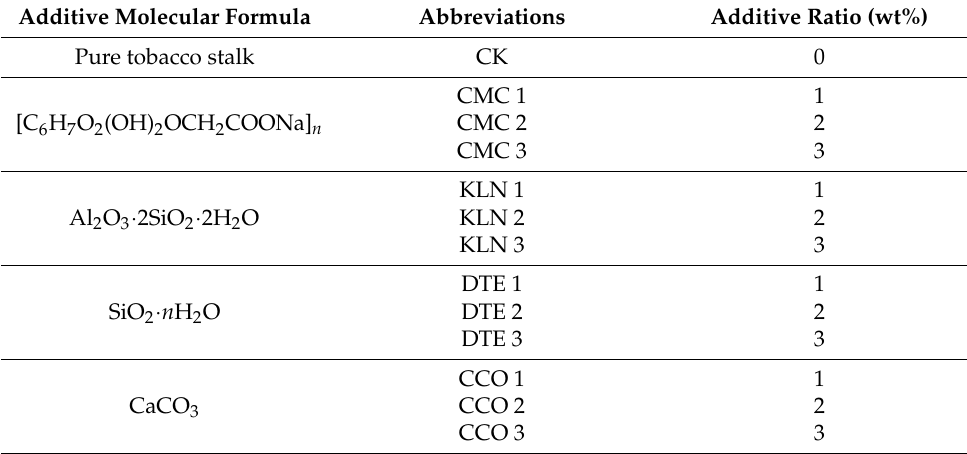
Table 1. Percentage of anti-slagging agents used in the experimental treatments for biomass pellet fuel made from tobacco stalks for flue-cured tobacco heating. Additive Molecular